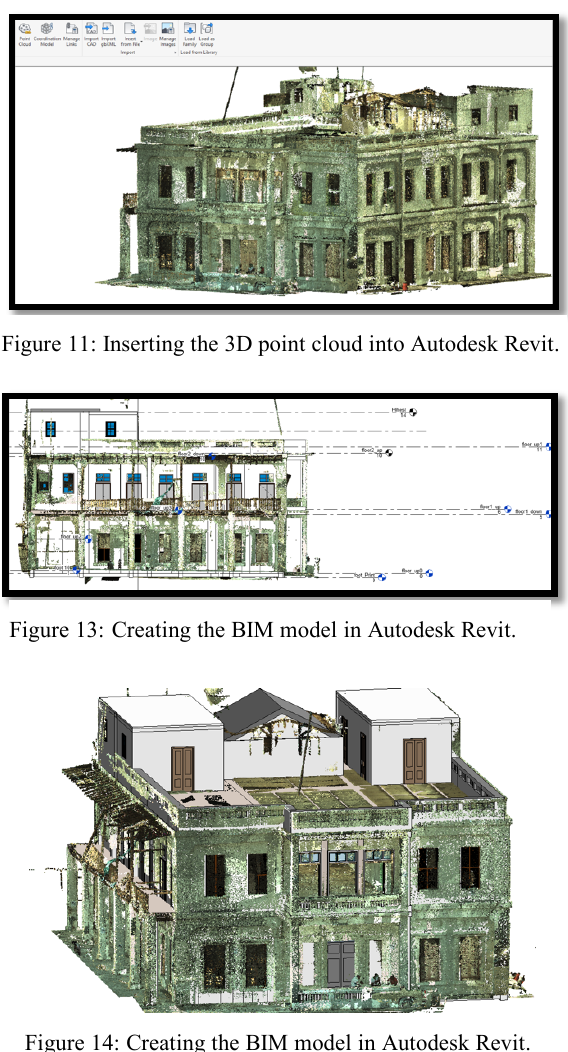
Figure 10: The 3D eBIM model of Bayt Zanal.